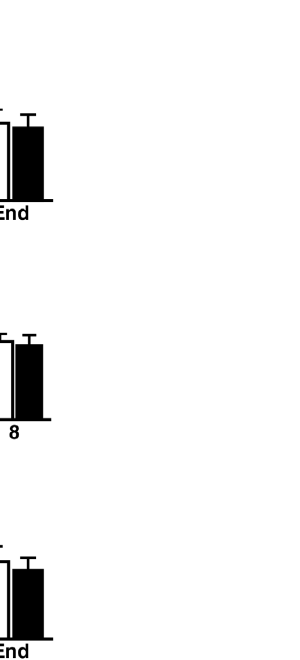
Fig. 2. Wildtype mice show no impairments in context or cued fear learning and memory after 2-hit injury. Wildtype mice (n 5 8–10 per group) received a 2-hit frontal impact injury or sham treatment, and underwent cued and contextual fear conditioning 1 month later. (A) On day 1, the sham-treated and 2-hit groups showed comparable amounts of freezing at baseline as well as during and between training trials. BL, baseline (3 min); CS, conditional stimulus (auditory stimulus followed by foot shock); IT, interval between CS (2 min); End, period following last CS (2 min). See methods for additional details. (B, C) Both groups also showed a comparable amount of freezing when they were introduced into the same context on day 2 without receiving an auditory stimulus or foot shock (B) or into a novel environment on day 3 after hearing the auditory stimulus without receiving a foot shock (C). AS, auditory stimulus. One-way ANOVA revealed no significant differences between the groups (A–C). Data are means ¡ SEM.